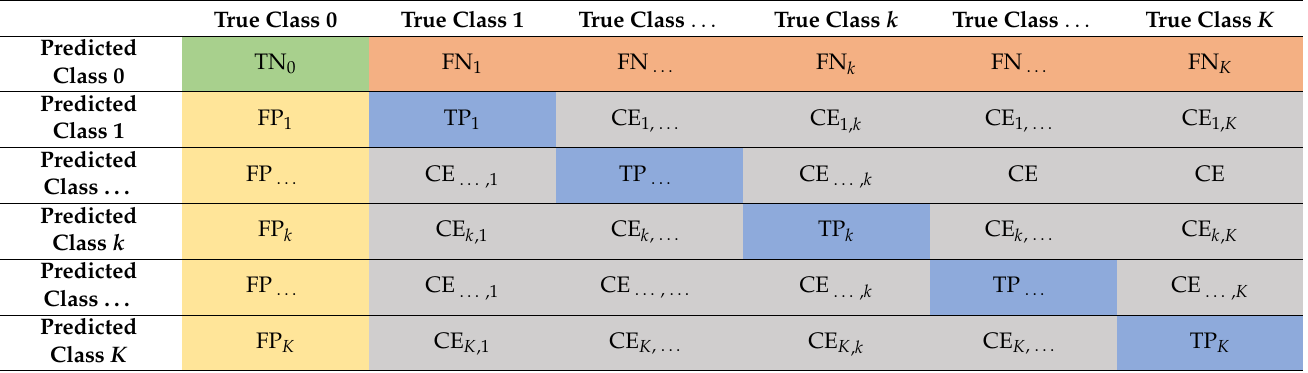
Table 1. A generic confusion matrix (TP = True Positive, FP = False Positive, FN = False Negative, TN = True Negative, CE = Class Error, TC = Total Cases) where k = 0 is the reference class and k = 1, . . . , K are the considered damage